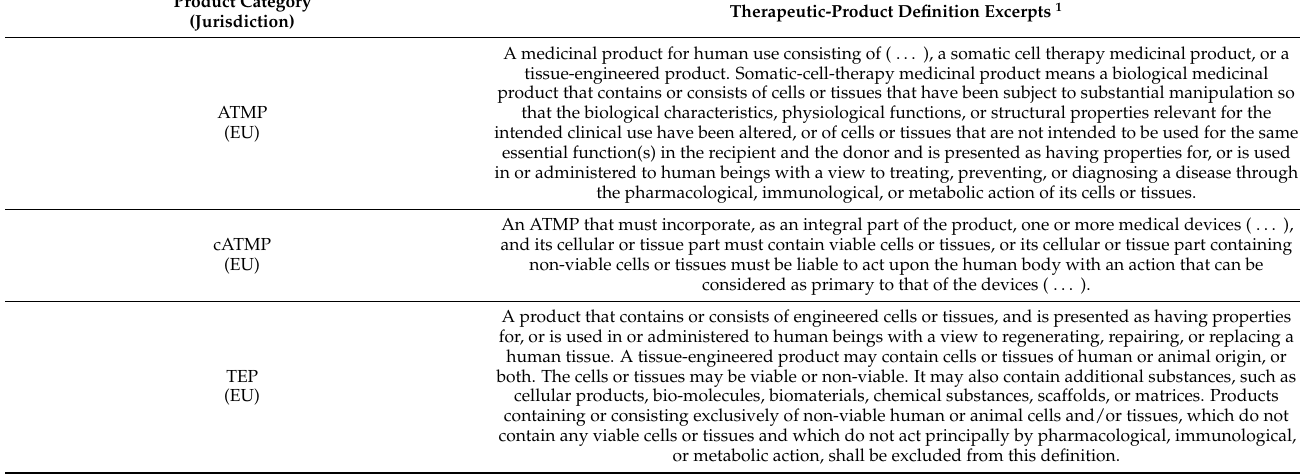
Table 5. Definitions pertaining to the various categories of therapeutic products containing or con- sisting of therapeutic cells in applicable Swiss and European laws and regulations [59,86–88]. ATMP, advanced therapy medicinal product; cATMP, combined advanced therapy medicinal product; CH, Helvetic Confederation; EU, European Union; TEP, tissue-engineering product; TrSt, standardized transplant